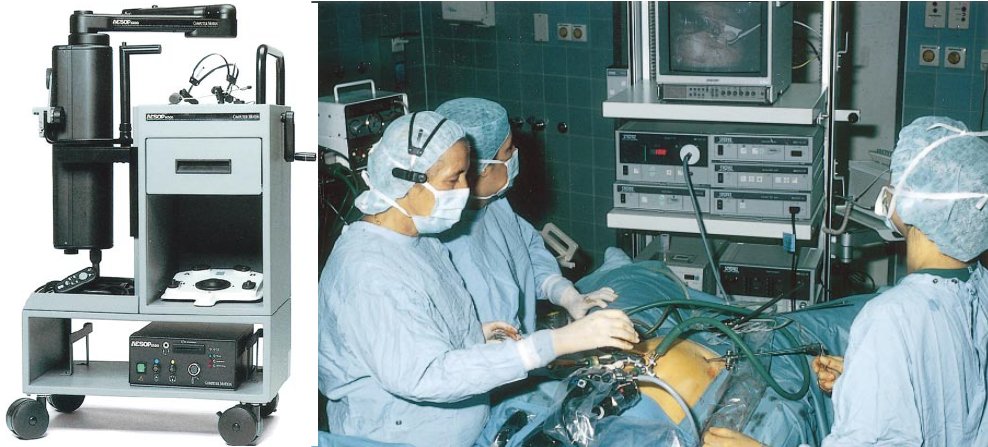
Figure 4. AESOP2000 and the endoscope surgery scene of using AESOP2000 (Computer Motion Company, Santa Barbara, CA, United States) [106].